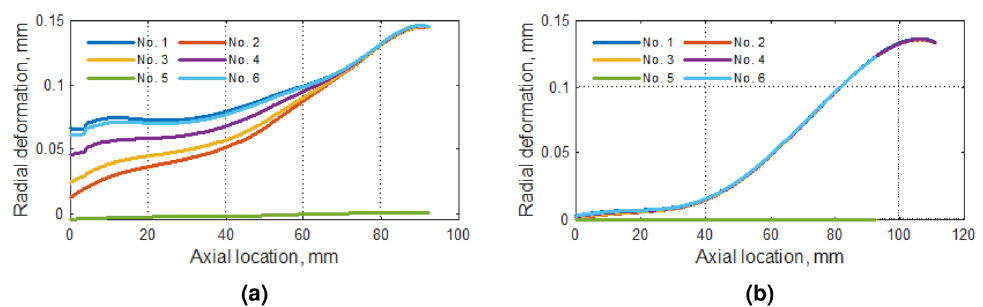
Figure 8. Radial deformation along ( a ) the tip of the blade and ( b ) rounding between the blade and the center of the